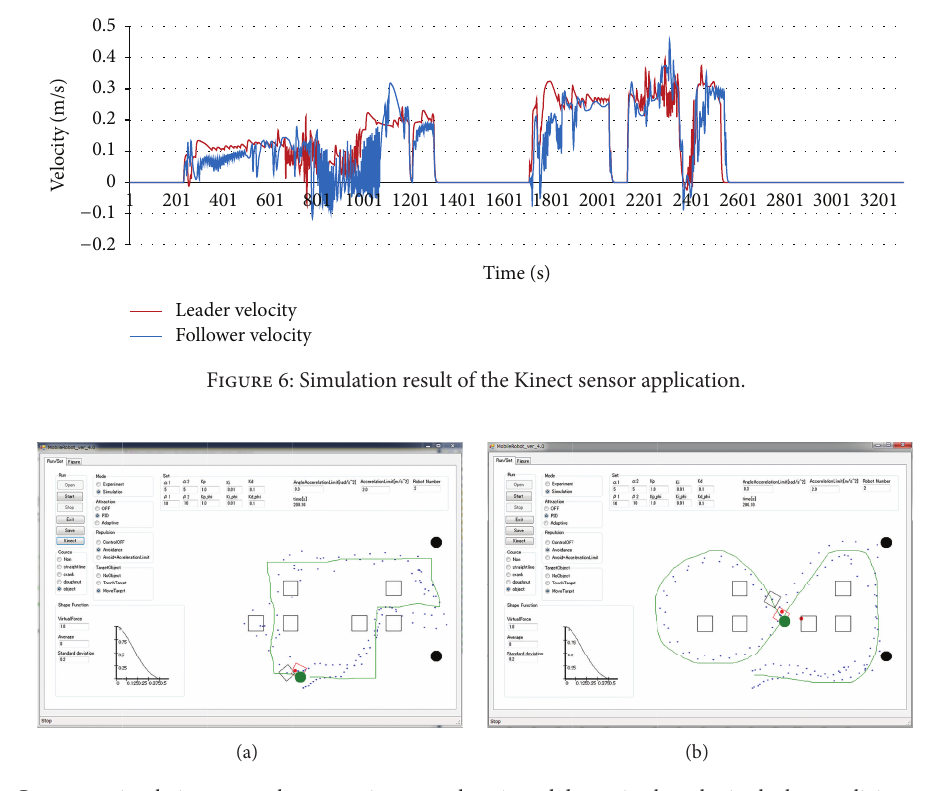
Figure 7: Computer simulation screenshot assuming several static and dynamic obstacles in the human living